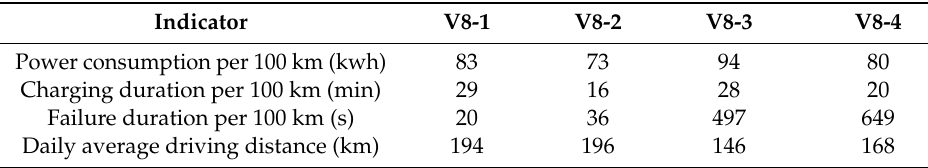
Table 8. Selection Factor Data for Group A.